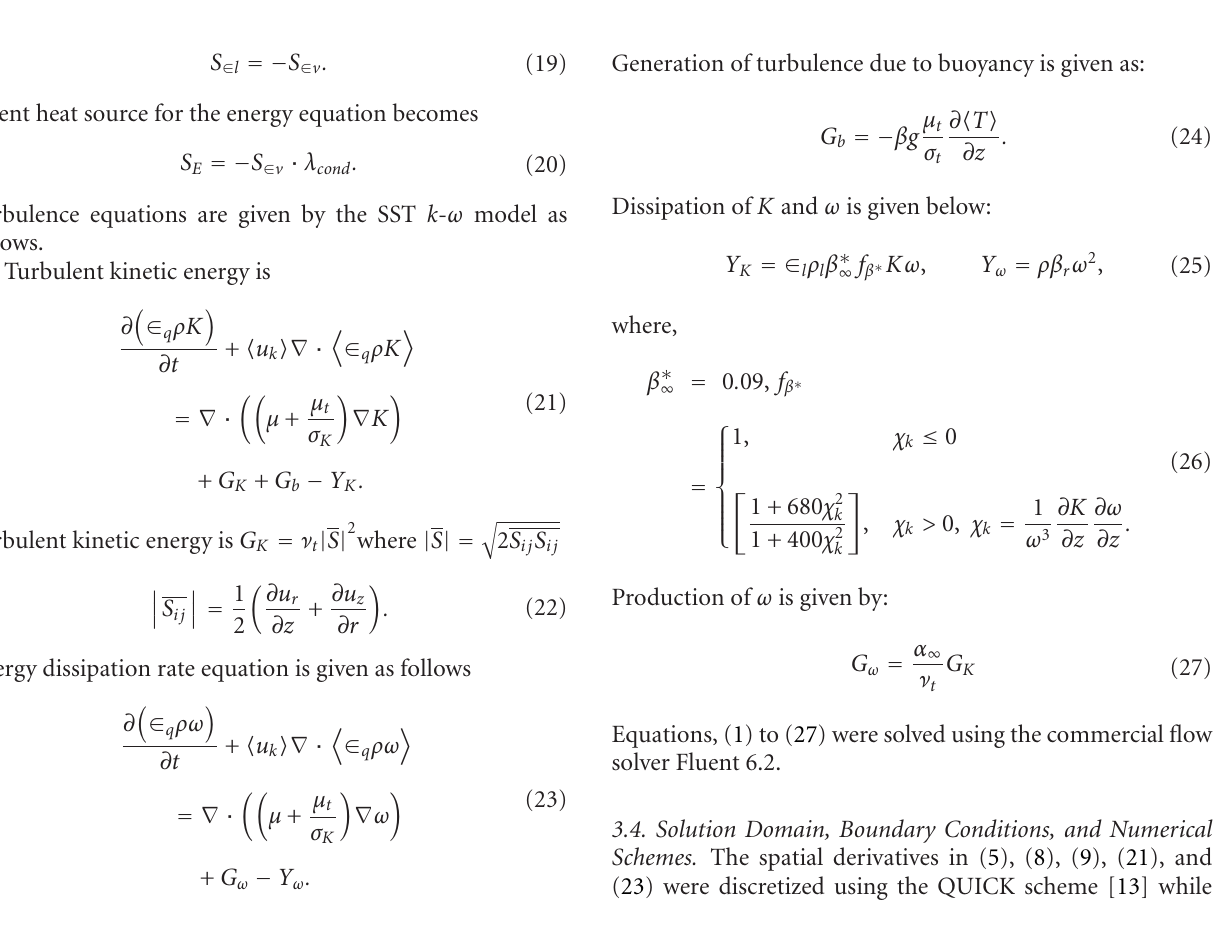
Figure 6: Velocity vectors showing the movement of the bulk fluid due to bubble